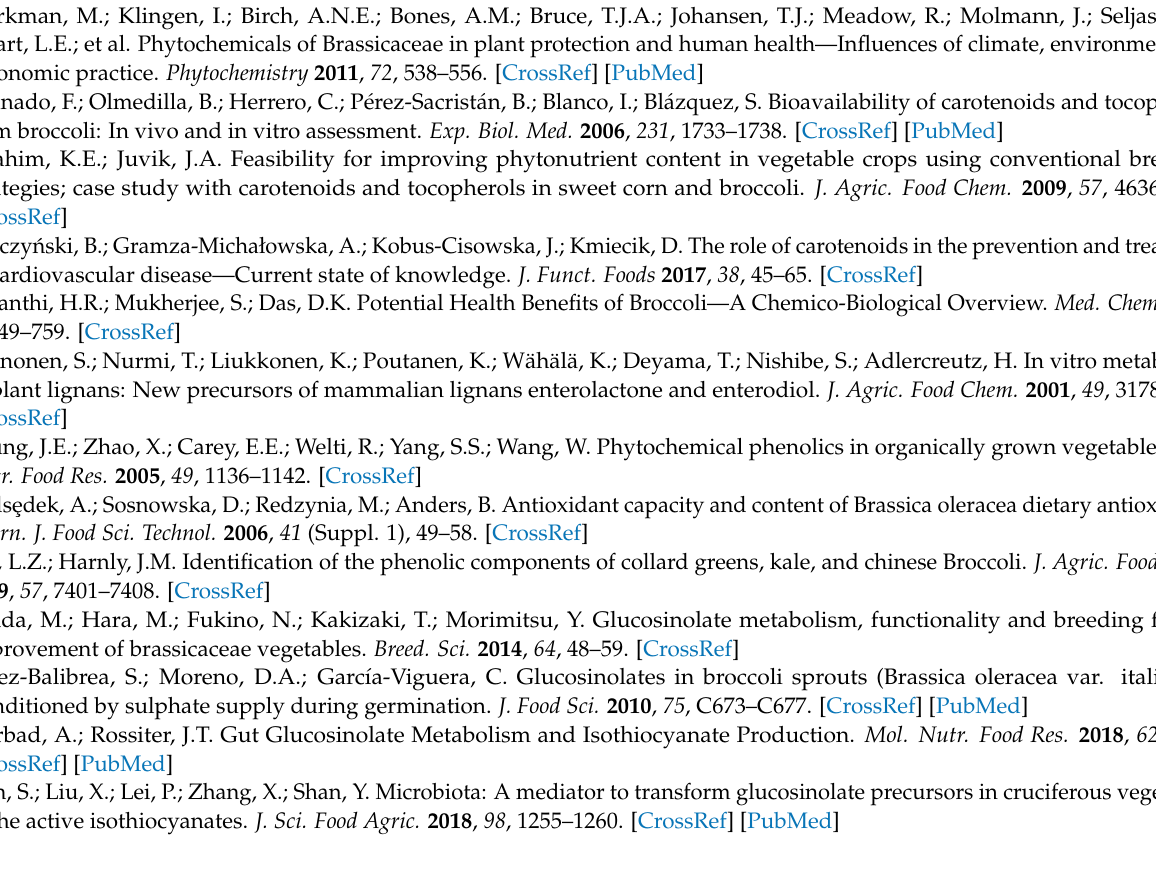
Figure A1. Total glucosinolates (GLS) levels converted to isothiocyanates with (+Myr) or without ( − Myr) Sinapis alba thioglucosidase added to frozen ( − 20 ◦ C for 15 days), boiled and steamed broccoli. Data are expressed as mg/100 g of vegetables ± SD of three technical replicates. ** p < 0.01 vs. boiled–Myr (b) and steamed–Myr (c).